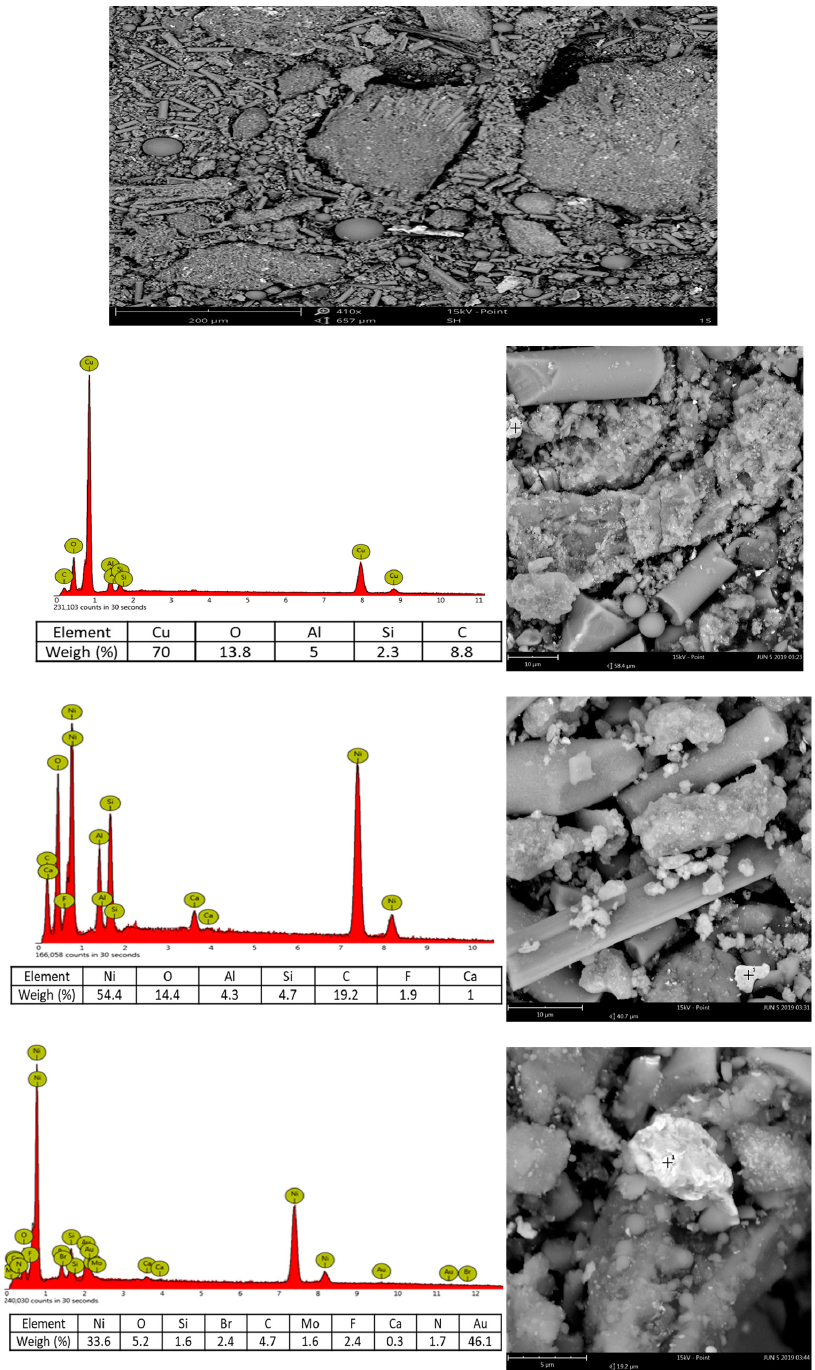
Figure 8. Scanning electron microscopy (SEM–EDS) images, micrographs, and microanalysis of the PCB sample before leaching.